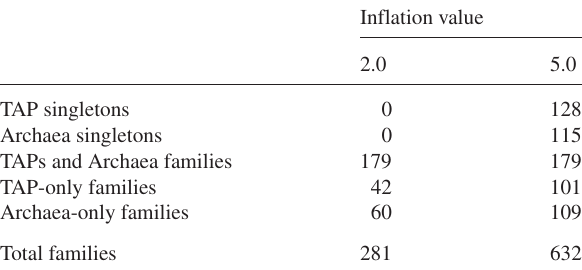
Table 2. Distribution of TRIBE-MCL protein families. Shown are the number of identified families at inflation values of 2.0 and 5.0, corre- sponding to different granularities (see